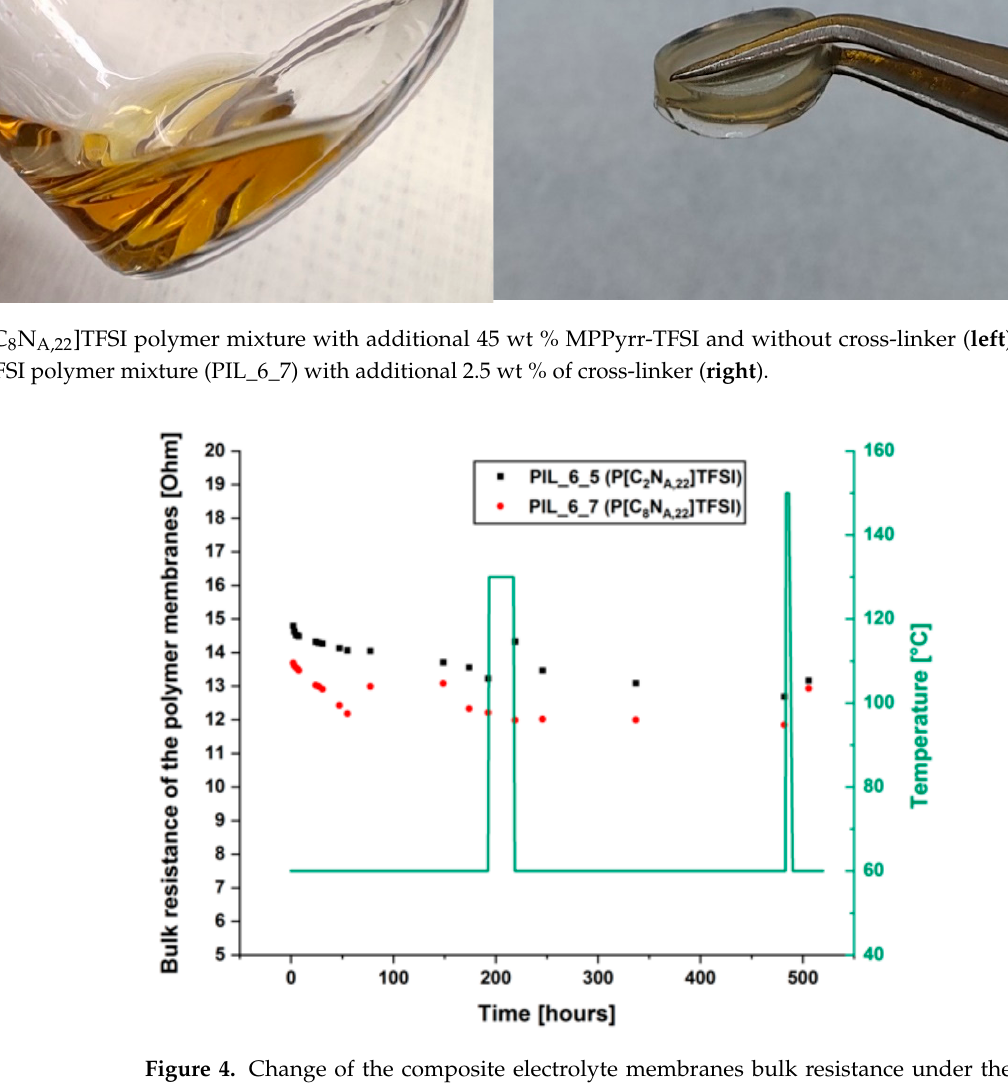
Figure 4. Change of the composite electrolyte membranes bulk resistance under thermal stress. Post-mortem membrane thicknesses of the samples are 99 µ m for PIL_6_5 and 61 µ m for PIL_6_7. Overall, the membranes were exposed to high thermal stress during the test, which should not occur under normal battery operation. The data show that the measured